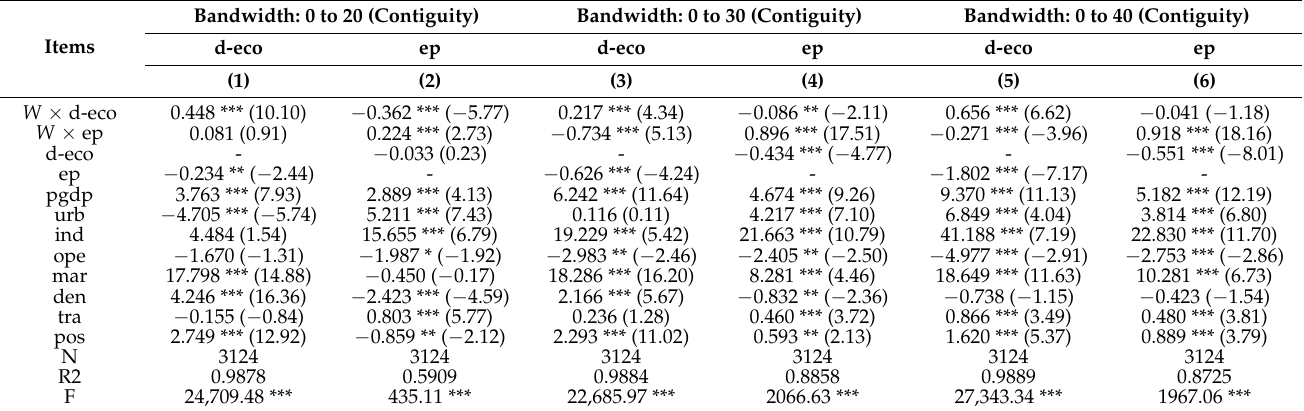
Table 6. Results of the matrix type